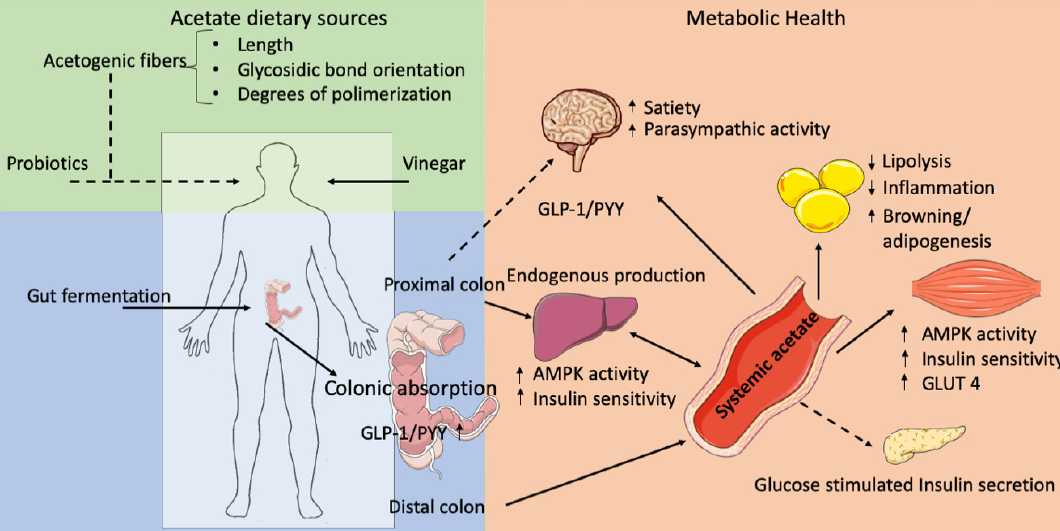
Figure 1. Acetate sources and acetate-mediated effects in metabolic health. Exogenous acetate production includes vinegar as well as the supplementation of acetogenic fiber and probiotics. Acetogenic fiber characteristics (e.g. length, glycosidic bond configuration) may determine acetate production. Endogenous acetate production occurs in all tissues but predominantly in the liver. Microbial acetate is mainly produced in the colon. Colonic absorption and acetate systemic concentrations may differ between colonic production sites (proximal/distal).